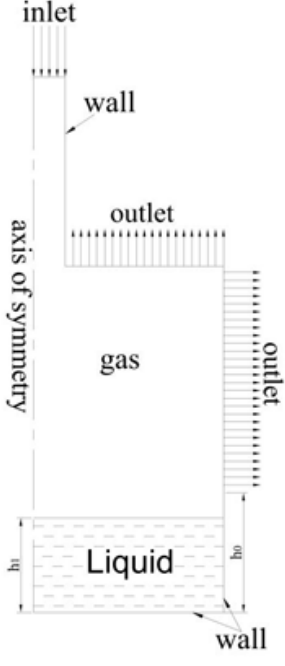
Figure 4. The model diagram of the gas jet forming.